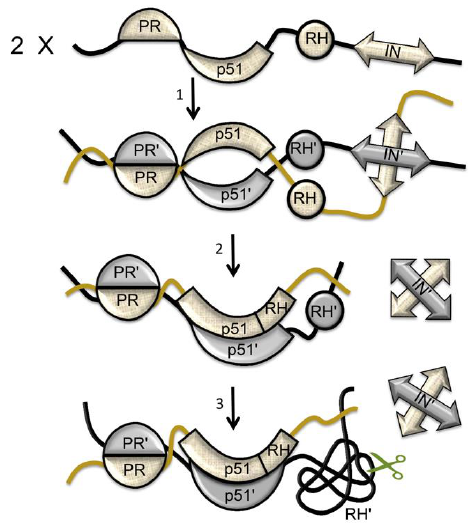
Figure 16. Polyprotein-dependent cooperative dimerization. Solvent-exposed dimer interfaces in the folded regions of Gag-pro-Pol presumably provide the initial nucleation sites for dimer formation ( 1 ). Formation of the initial polyprotein homodimer facilitates p51 dimerization, since a p51 binding partner is positioned nearby to capture the (rare) isomerized p51 structure ( 2 ). Early cleavage releases the integrase (IN) dimer, followed by the transfer of residues from RH’ to p51’, leading to the destabilization and unfolding of RH’, and to the exposure of the RH’ cleavage site, indicated by the green scissors ( 3 ). Cleavage of protease (PR)-p51 occurs near the end of proteolytic processing.